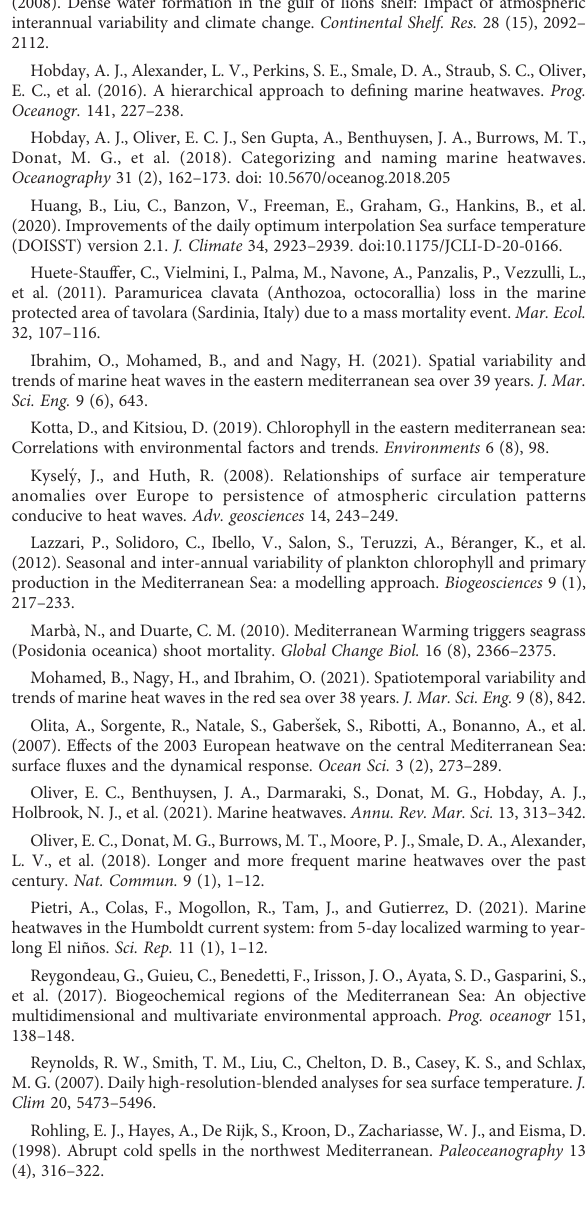
and the eastrern Mediterranean (green line) of MHWs in JJAS (left) and MCSs in DJFM (right). Dashed lines represent quadratic regression of the solid lines with the same color. SUPPLEMENTARY TABLE 5 Top 30 summer in terms of MHW total activity for the Mediterranean (left column), the western Mediterranean (middle column) and the eastern Mediterranean (right